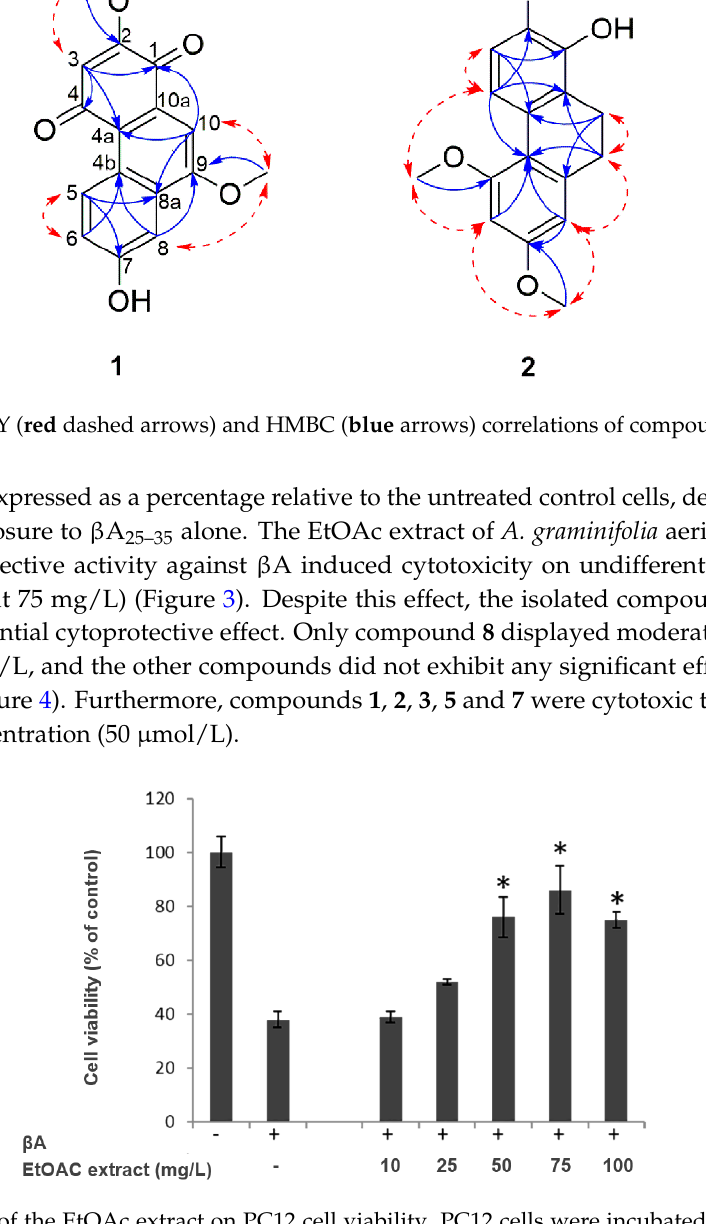
Figure 3. Effect of the EtOAc extract on PC12 cell viability. PC12 cells were incubated with EtOAc extract (10, 25, 50 and 100 mg/L) for 24 h, and then exposure to 5 µ M of β A for 24 h. Results are expressed as mean ± SD ( n = 4). * p < 0.05 as compared to the β A treated group.